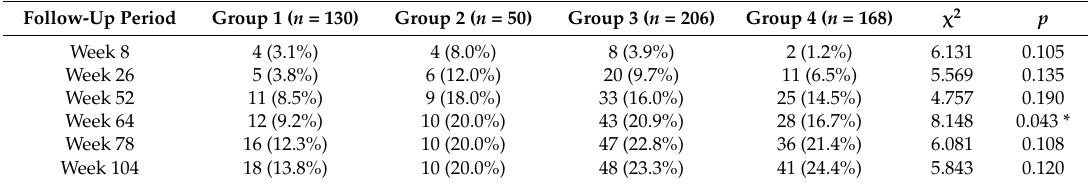
Table 3. The number of accumulative relapse and accumulative relapse rate of four groups in each follow-up